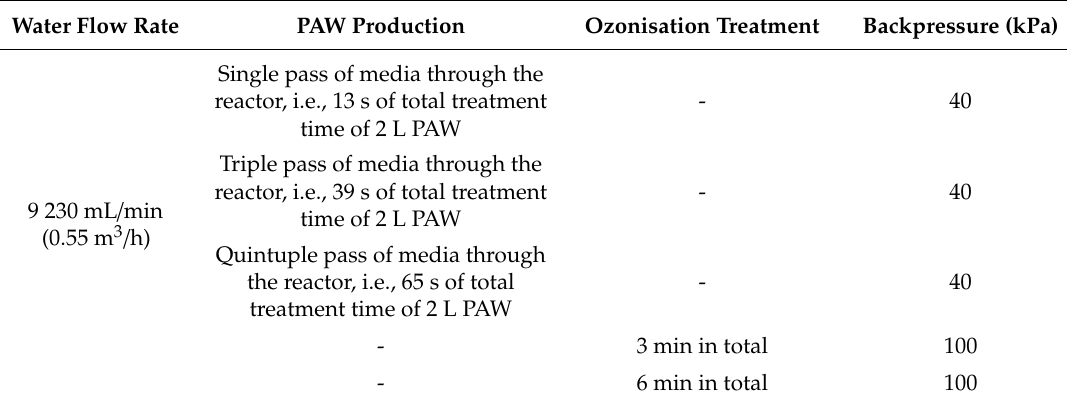
Table 2. Treatment conditions of